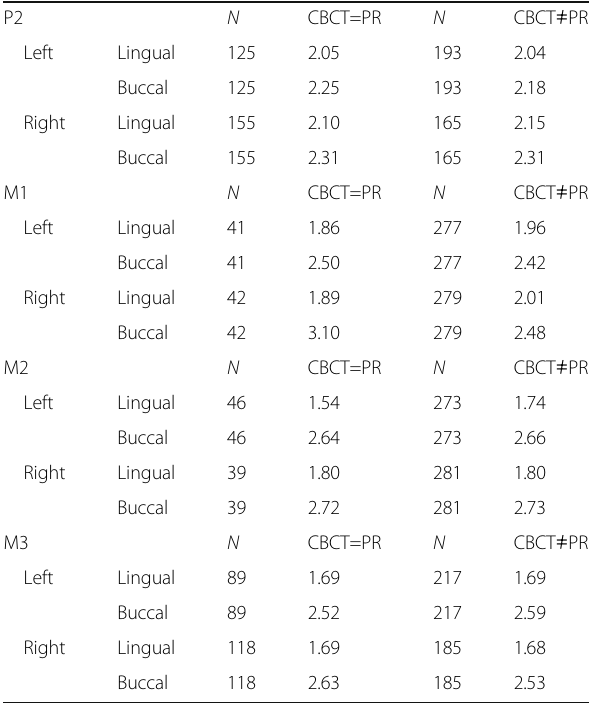
Average values of the thickness of the cortical bone (in mm) in the individual jaw sections P2, M1, M2 and M3 respectively left and right as well as buccally and lingually, with consistent visibility of the CM (CBCT=PR) and with discrepancy (CBCT ≠